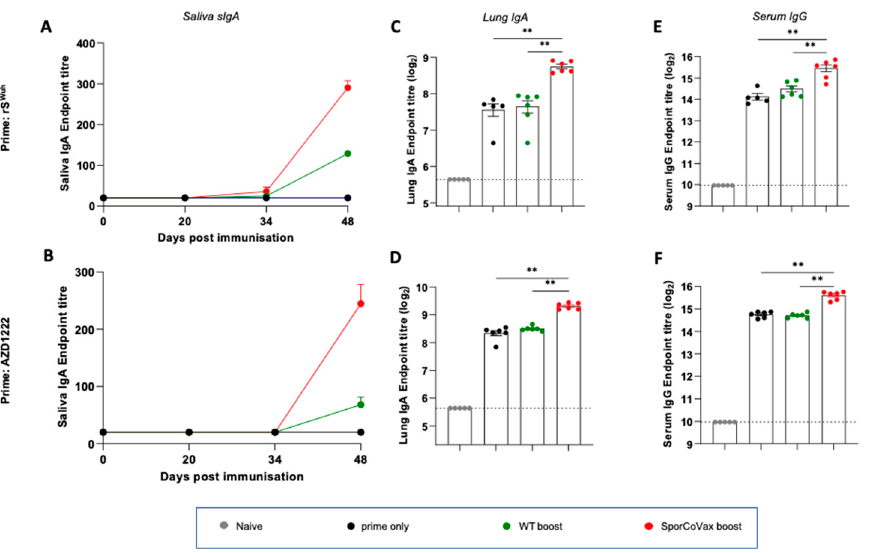
Figure 2. Intranasal boosting of a subunit prime or AZD1222. Female BALB/C mice were primed (i.m.) with recombinant Spike (rS Wuh ) or AZD1222 (1.0 × 10 8 IU) followed by two intranasal boosts with 1 × 10 9 spores of either WT (naked spores, no antigen expression) or SporCoVax (1:1 mixture of CotB-RBD Wuh ) and CotC-HR1-HR2 Wuh spores) three and five weeks post prime. Panels show S Wuh -specific responses determined by ELISA (OD 450 nm ) 48 days post immunization. Panel ( A , B ) rS Wuh -specific sIgA in longitudinal saliva samples, ( C , D ) rS Wuh -specific IgA in the lungs, ( E , F ) rS Wuh -specific IgG in serum. Mann–Whitney, ** p < 0.01. Using a similar systemic prime–mucosal boost regimen, we primed (i.m.) mice with